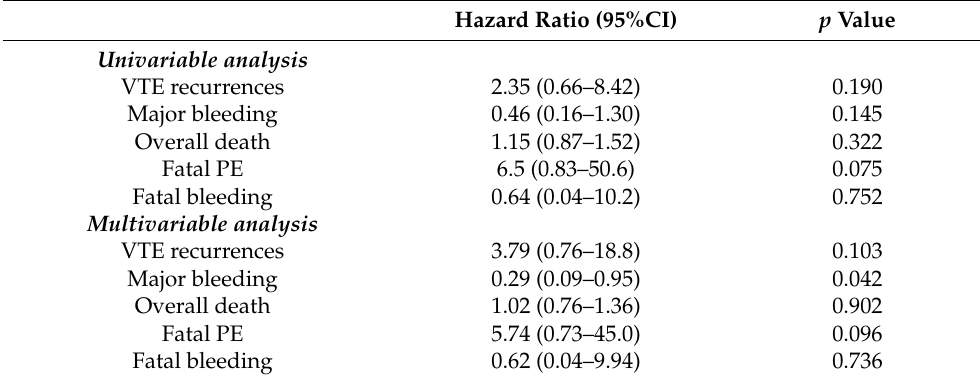
Table 4. Univariable and multivariable analyses for adverse events during the course of anticoagula- tion, according to cancer histology (adenocarcinoma vs.